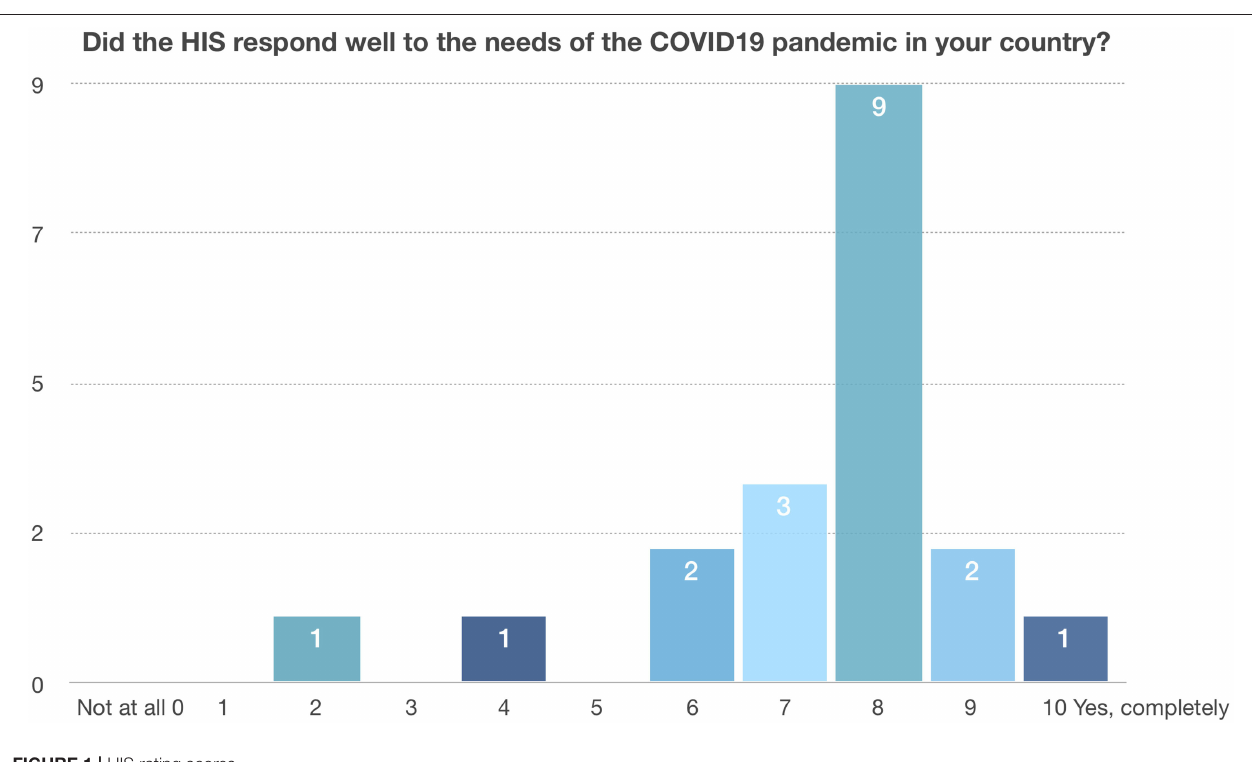
FIGURE 1 | HIS rating